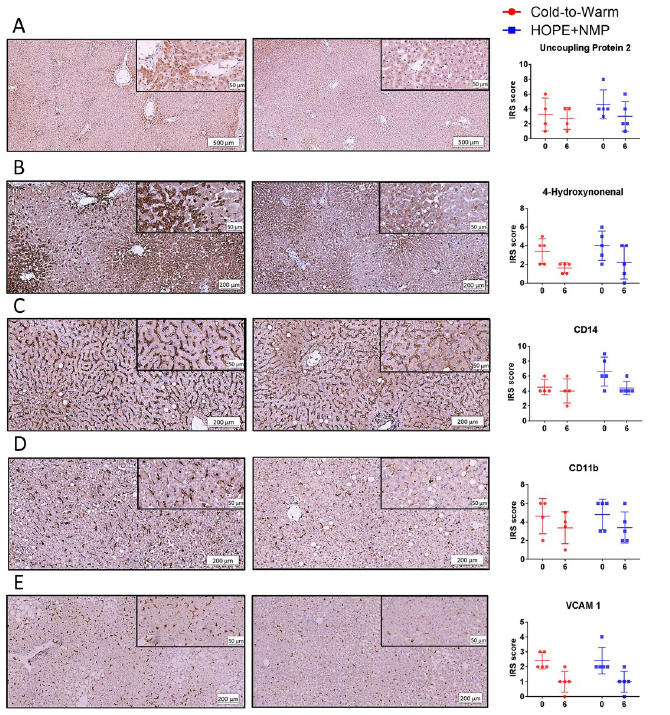
Fig 6. Immunohistochemical assessment of oxidative tissue injury and activation of the inflammatory cascade. Panel A shows the tissue expression of the uncoupling protein 2, a marker for reactive oxygen species (ROS) generation; the left-hand picture shows a moderate diffuse reaction of the staining at time 0, mainly localised at peri- portal areas, which changed to a mild reaction at the end of the 6 hours perfusion. The graph on the right shows the variation in the two groups at these time points. This downregulation in ROS production is associated with a reduction in tissue expression of 4-hydroxynonenal (4-HNE) (Panel B), an established marker for lipid peroxidation during oxidative stress. The lowered oxidative injury decreases the tissue expression of the cluster of differentiation (CD)14 in macrophages (Panel C). CD14 is part of the signalosome of the toll-like receptor 4, which in turn leads to the activation of inflammatory and endothelial cells, perpetuating and aggravating tissue injury. In accordance, a downward trend can be seen during the perfusion in the presence of activated leukocytes, identified by the expression of the CD11b (Panel D) and activated endothelial cells, as represented by the expression of the vascular cell adhesion molecule 1 (VCAM-1) (Panel E). Therefore, both combined protocols exhibited a similar decreasing trend in the expression of markers of ischaemia-reperfusion injury during the perfusion. In the graphs, dots represent individual organs at the time points, and the line is the median of the values for each group.